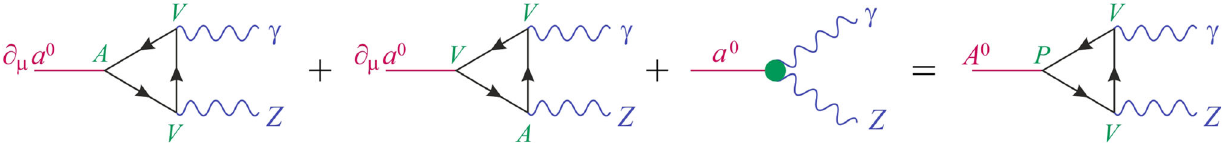
Fig. 3 Representationofthecontributionsto a 0 → γγ, gg inthepolar representation, and their matching with the A 0 → γγ, gg amplitude of the linearly realized theory. The notation P , V , A denotes pseudoscalar, vector,andaxialvertices,thatis, γ 5 , γ μ ,and γ μ γ 5 Diracstructures.The